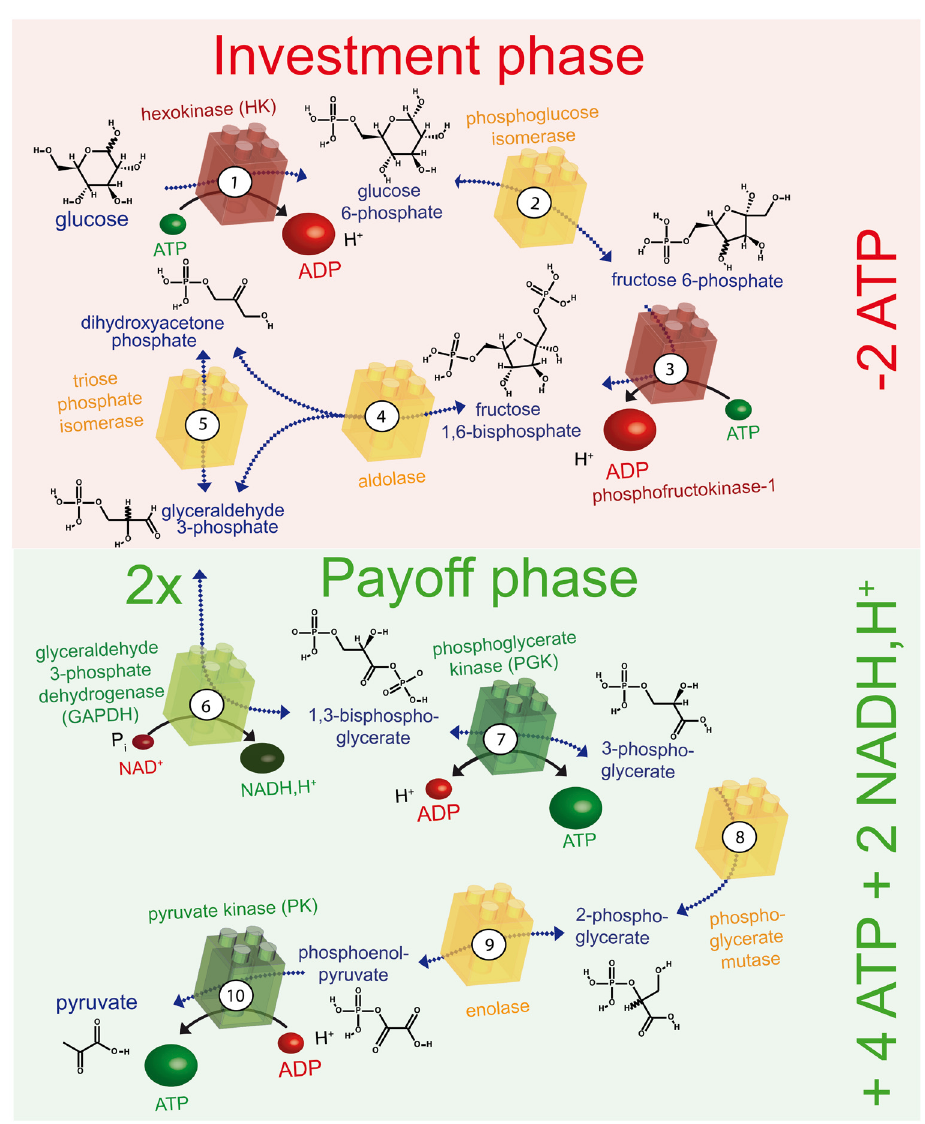
Figure 3. The glycolytic pathway. The ten enzyme-catalysed steps of glycolysis that convert glucose to pyruvate are illustrated. The enzymes shown in red consume ATP, those shown in green produce ATP or NADH and H + , and those shown in yellow are energetically neutral. In the preparatory phase, energy is invested (-2ATP) and in the payoff phase energy is produced (+4ATP +2NADH, H + ), as indicated on the right. ADP, adenosine diphosphate; ATP, adenosine 5’-triphosphate; NADH,H + nicotinamide adenine dinucleotide.